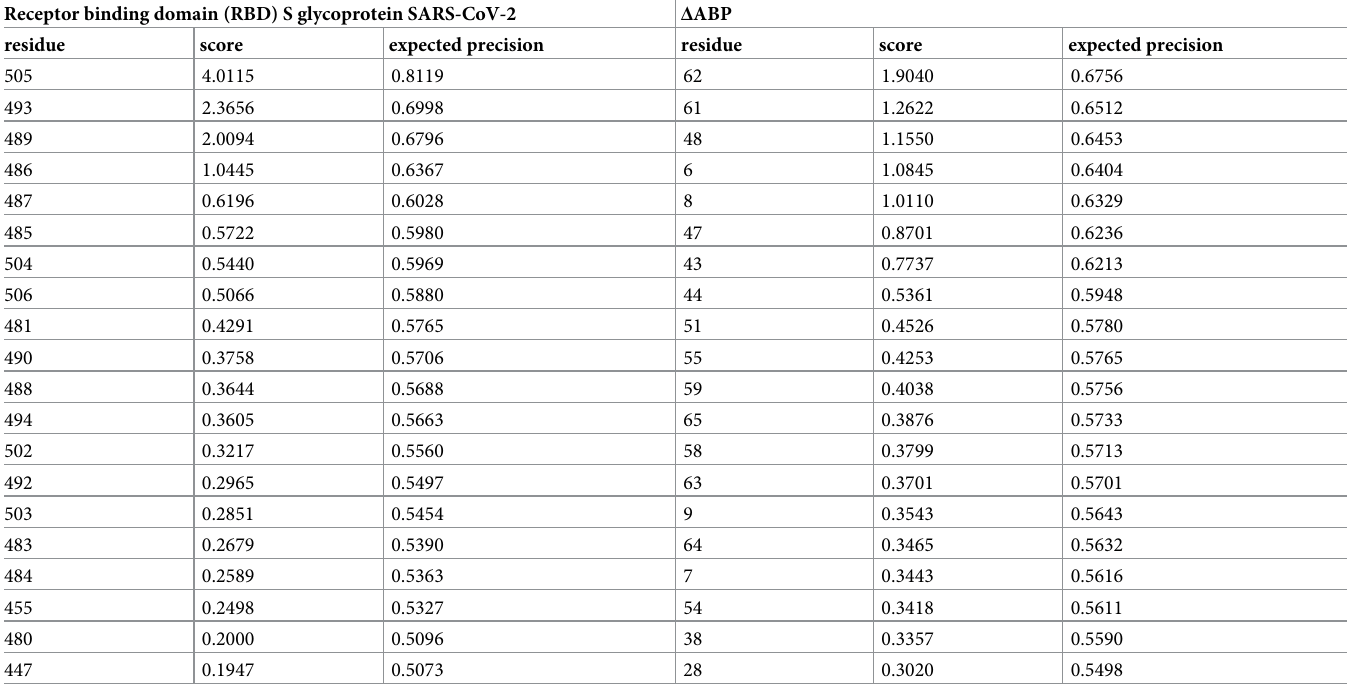
Table 3. BIPSPI server prediction of binding interface of RBD and Δ ABP peptide. Receptor binding domain (RBD) S glycoprotein